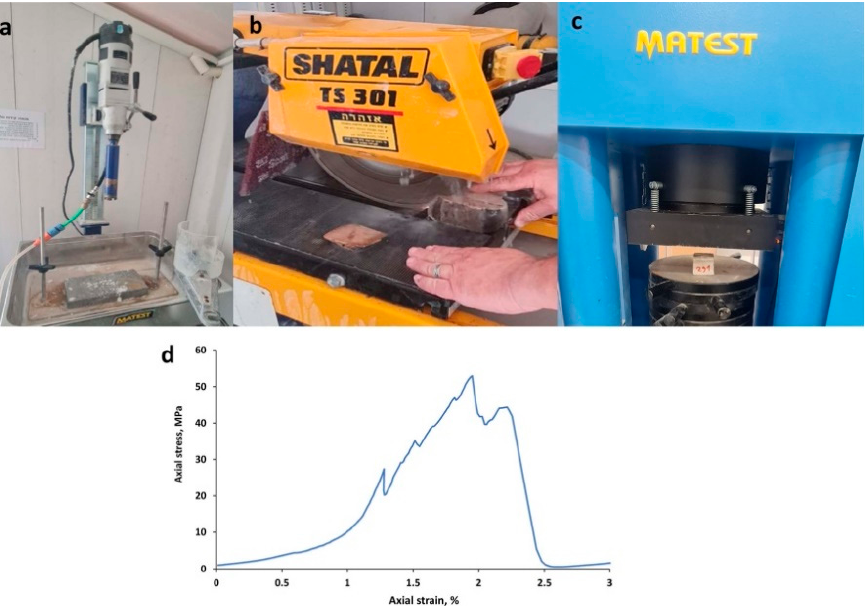
Figure 8. ( a ) The drilling machine used in attempts to prepare cylindrical samples for the strength study; ( b ) the Shattal Diamond Disk Saw used for the cubic samples’ preparation; ( c ) the typical cubic sample within the compression machine; ( d ) The typical strain-stress diagram.